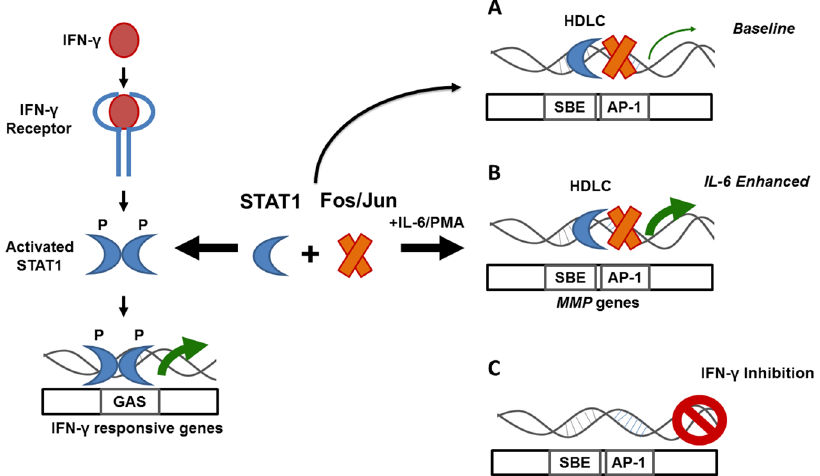
Figure 5. Proposed model for the regulation of MMPs by IL-6/PMA and IFN- γ . Fos/Jun and non- phosphorylated STAT-1 bind constitutively to AP-1 and SBEs elements in the MMP-1 and MMP-3 proximal promoters, maintaining a basal level of gene expression ( A ). In the presence of IL-6 or PMA, MMP expression is enhanced (green arrow) ( B ). In response to IFN- γ , STAT-1 is phosphorylated, increasing its affinity for binding to GAS elements in the promoters of IFN- γ responsive genes, displacing STAT-1 from the HDLCs in the MMP gene promoters, resulting in a reduction in expression of these genes ( C